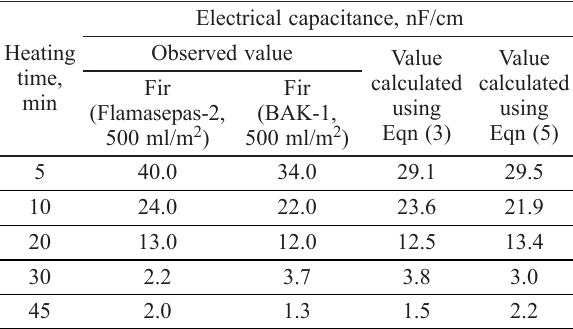
table 3. the observed and predicted electrical conductivity values of treated wood in the individual specimen electrical conductivity, Heating time, min